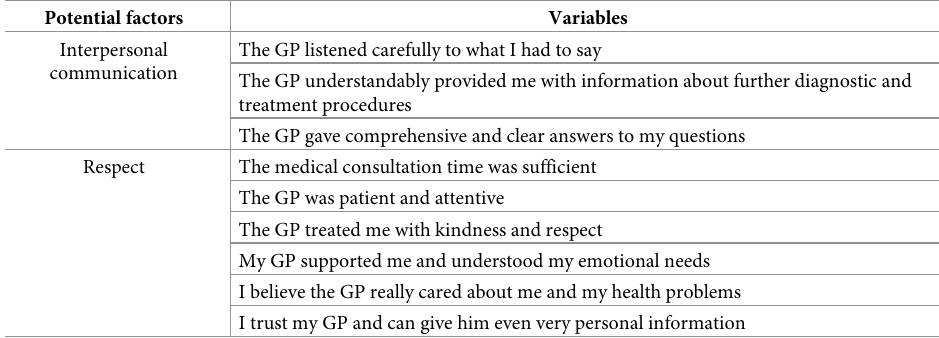
Table 1. Variables used to measure the quality of communication with